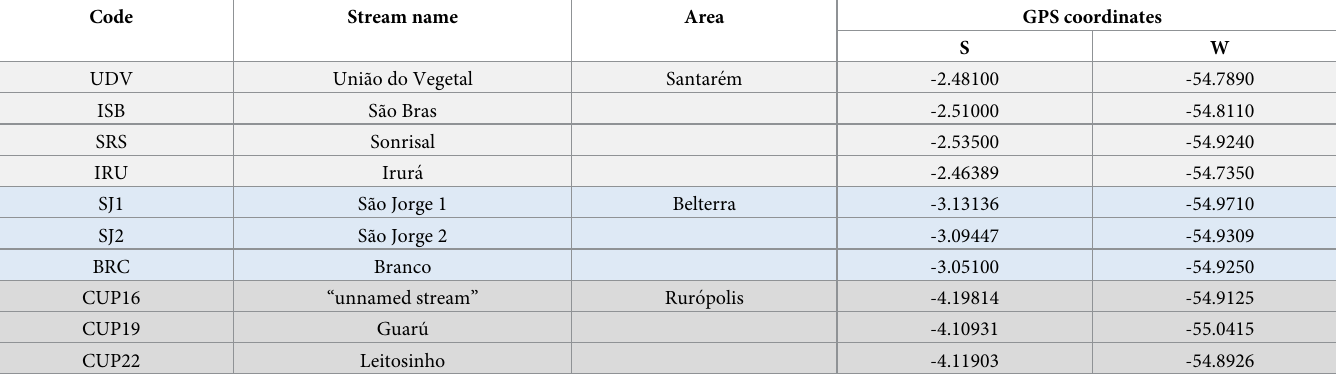
Table 1. Geographic data of stream sites surveyed for fish assemblages at the region of lower Tapajo´s River.